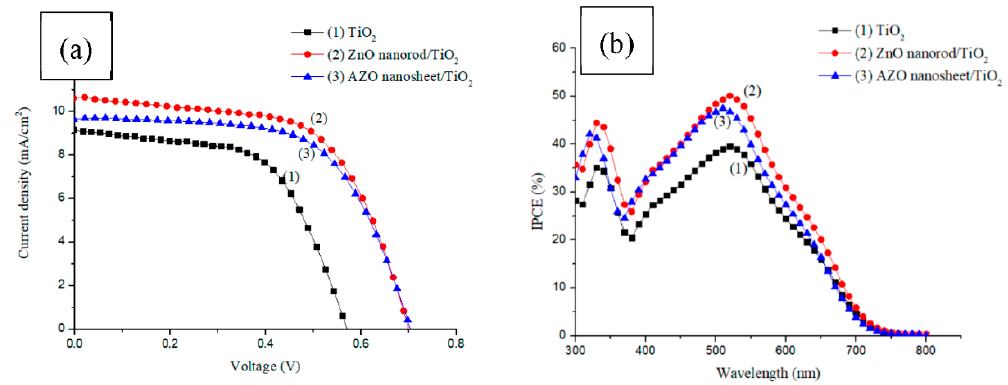
Figure 9. ( a ) J - V curves of different photoanodes. ( b ) IPCE of DSSCs with different photoanodes.